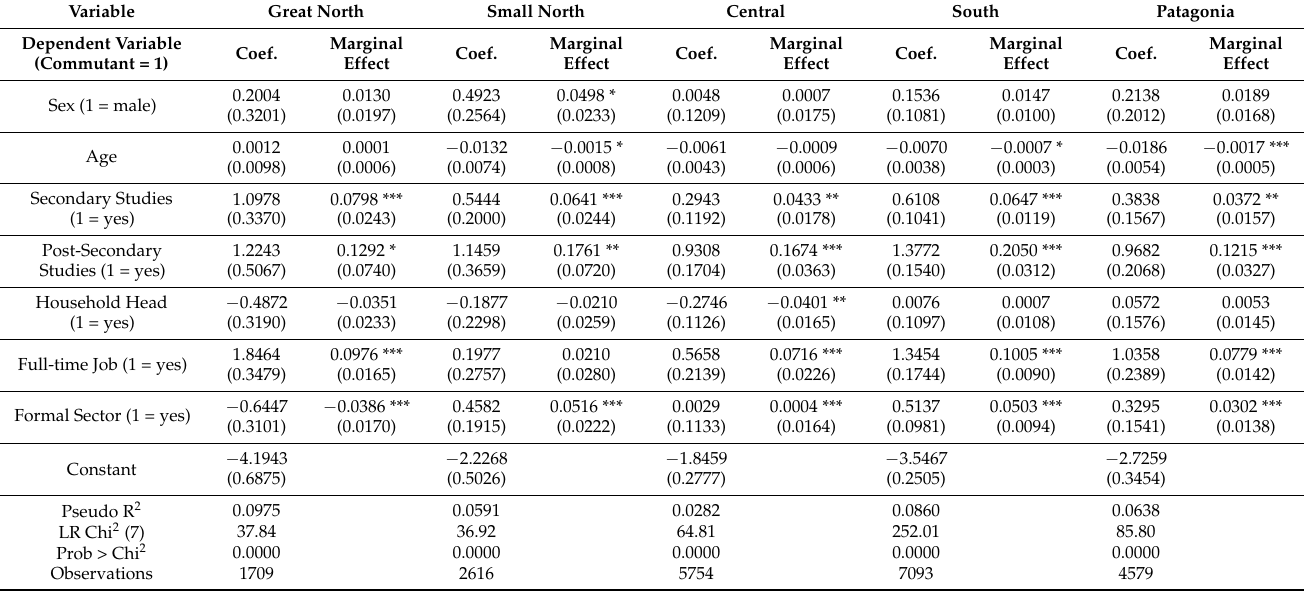
Table 4. Logistic estimation result and marginal effects by